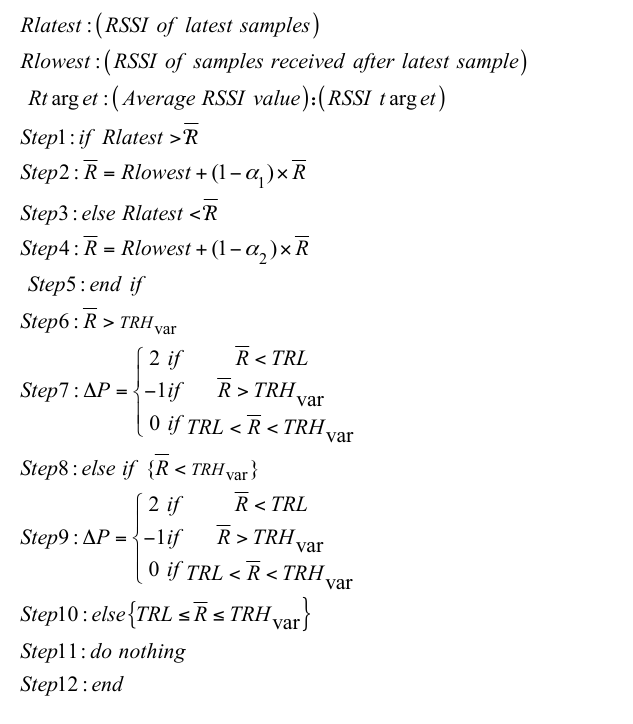
Figure 6. Pseudo code of the proposed transmission power control (TPC)-based energy-efficient (ETPC) algorithm. RSSI : received signal strength indicator; R : average RSSI ; TRH var : variable higher threshold; TRL : constant lower